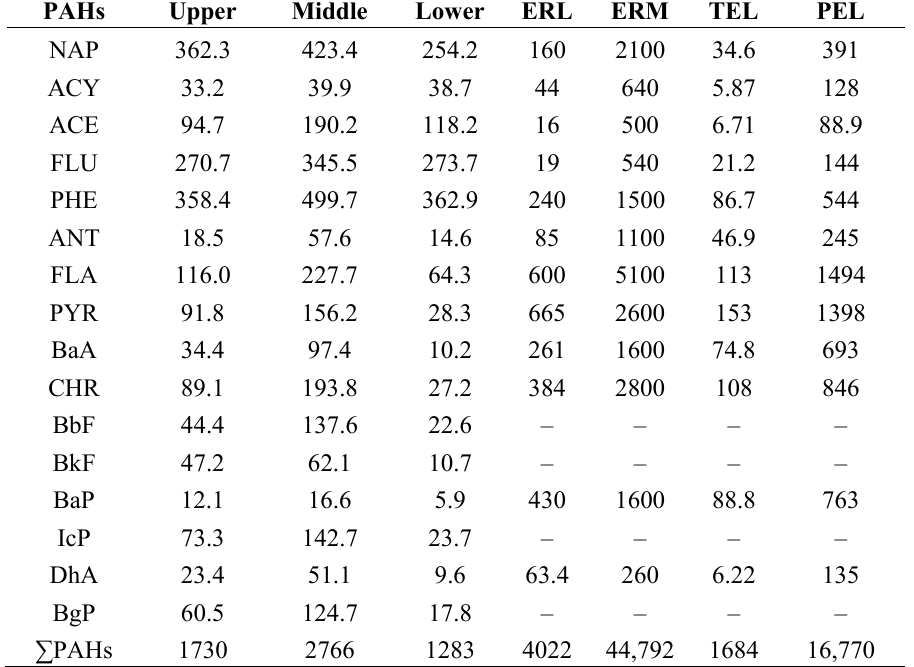
Table 4. ERL a , ERM b , TEL c and PEL d guideline values for polycyclic aromatic hydrocarbons (ng/g